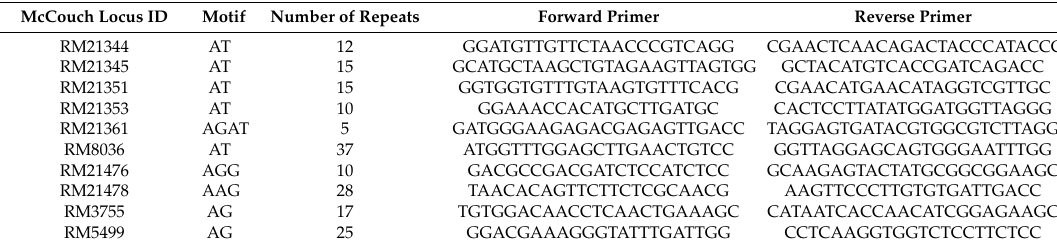
Table 4. Simple Sequence Repeats (SSR) markers, core sequence and no. of repeats along flanking DNA sequences, used for correlation analysis of genotypic variation with phenotypic (cold tolerance) attributes at booting stage in Towada NILs.